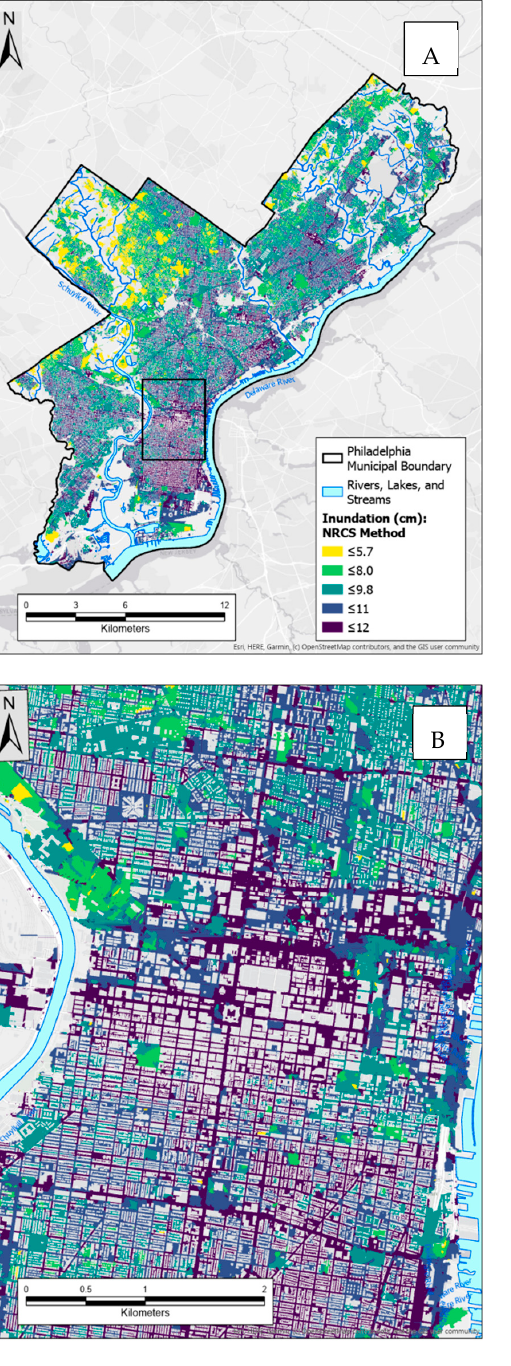
Figure 2. Comparison of estimated runoff depths predicted by the NRCS ( A,B ) and rational method ( C,D ) for city of Philadelphia and Center City for 24-hour, 10-year storm.